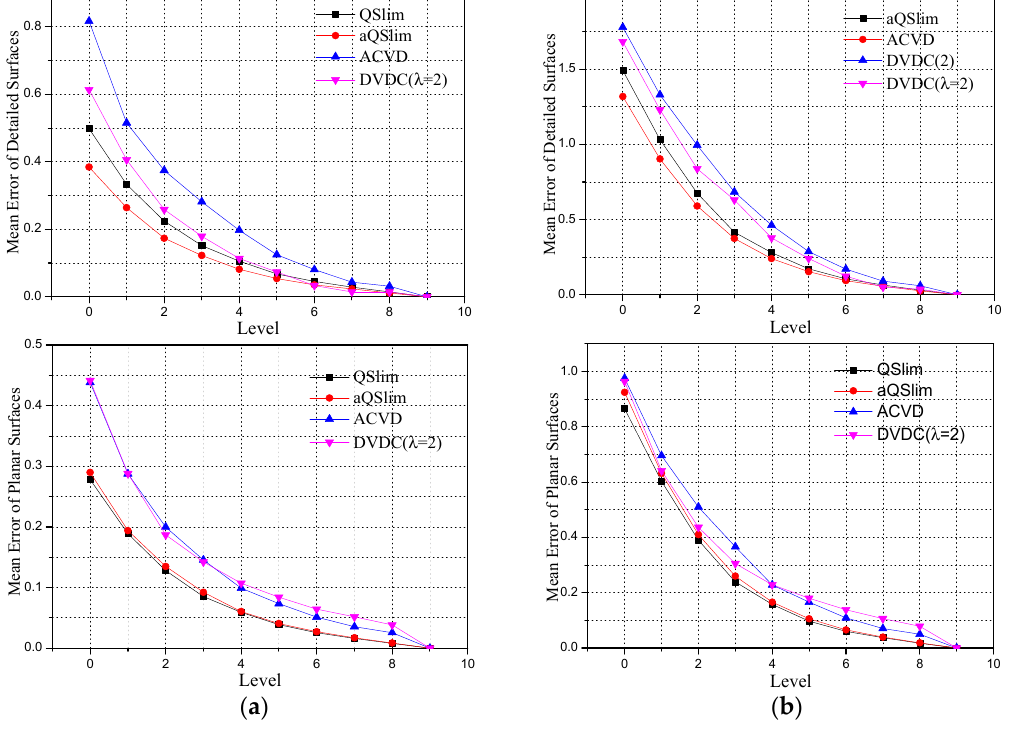
Figure 13. Mean error of detailed and planar surfaces. aQSlim clearly performs much better in terms of the mean error of detailed surfaces because aQSlim involves projecting the area into the QEM, which enhances the simplification rate for planar surfaces in urban surfaces. As expected, aQSlim performs worse in terms of the mean error of planar surfaces. ACVD and DVDC ( λ = 2) still perform worse in terms of both aspects because of the much higher comprehensive error. ( a ) Scenery 1; ( b ) Scenery 2.